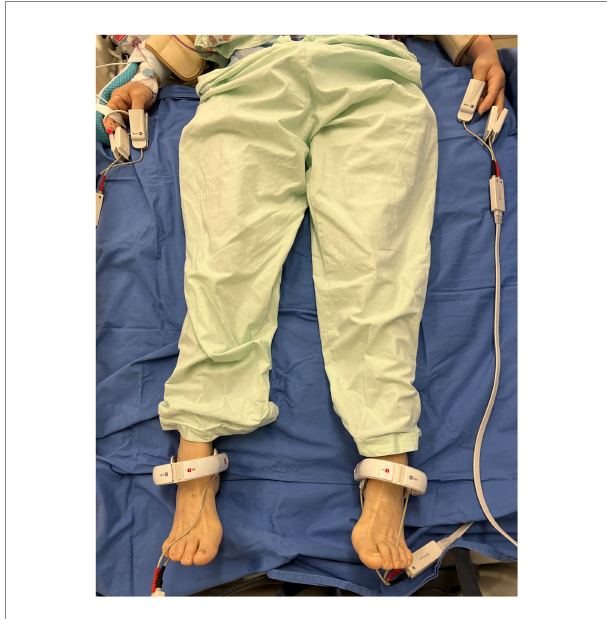
FIGURE 1 Electrodes placement for bioelectrical impedance